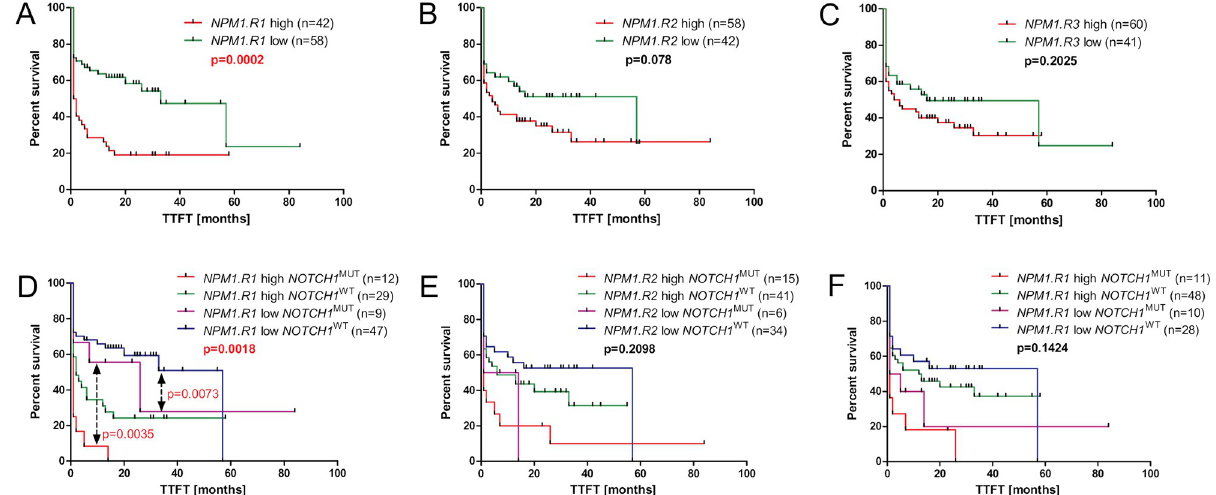
Fig 4. Time to first treatment (TTFT) curves of patients stratified by the combined analysis of NPM1 variants expression and NOTCH1 mutation status. Schemes presenting TTFT of CLL patients, according to: (A-C) different NPM1 transcripts levels and (D-F) both NPM1 transcripts levels and NOTCH1 mutation status. Clinically, the prognostic significance in terms of the TTFT was defined as the time from diagnosis to the start of treatment (according to the criteria for treatment proposed by the International Workshop on Chronic Lymphocytic Leukemia). Statistically significant p values are indicated in red.